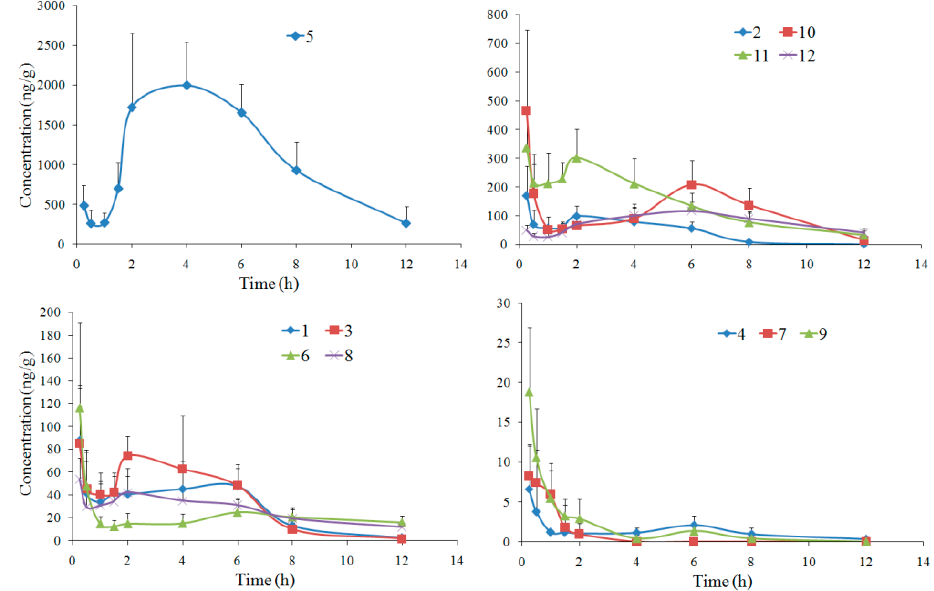
Figure 4. Mean concentration-time curves of twelve compounds in rat brain after oral administration of APRE (mean ± SD, n = 6). Table 3. Pharmacokinetic parameters of eleven analytes * in rat brain after oral administration of APRE (mean ± SD, n = 6).